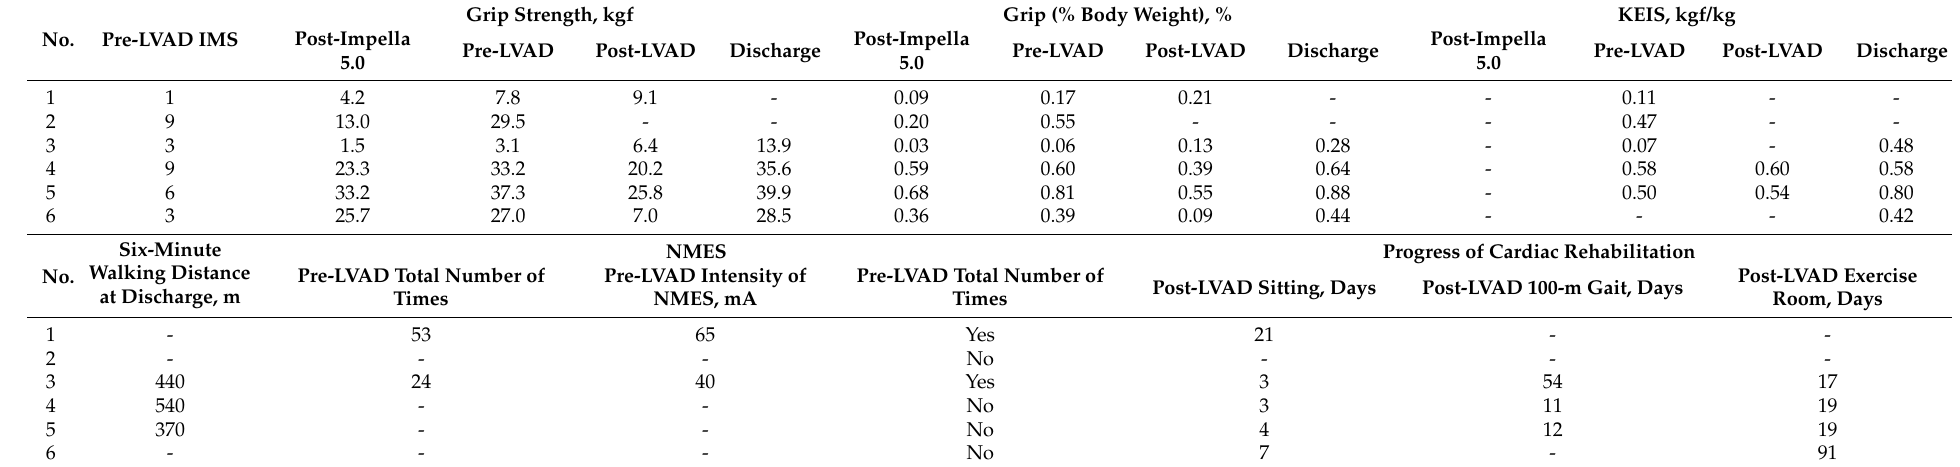
Table 3. Indices of cardiac rehabilitation post-Impella 5.0 implantation, pre-/post-LVAD implantation, and at